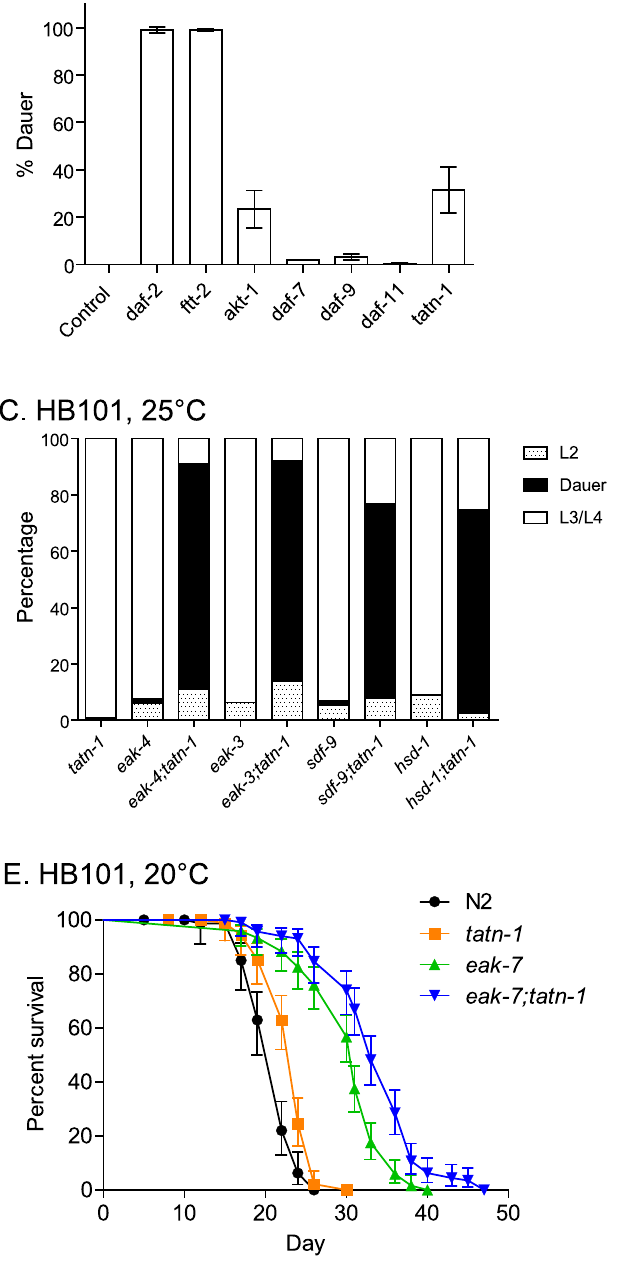
modest effect on dauer formation by eak-4(mg348); tatn-1(baf1) mutants (51% with akt-1(mg144) versus 77.6% without) (Figure 4C). Together these results suggest that the interaction between eak-4